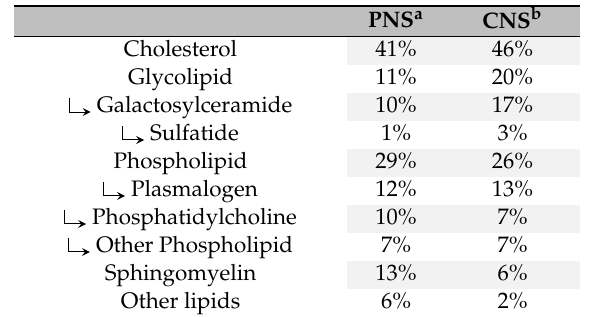
Table 1. Comparison of the lipid composition of peripheral nervous system (PNS) and central nervous system (CNS) myelin. Myelin in the adult bovine spinal root and brain. a O’brien et al. 1967 [27]; b Norton and Poduslo 1973